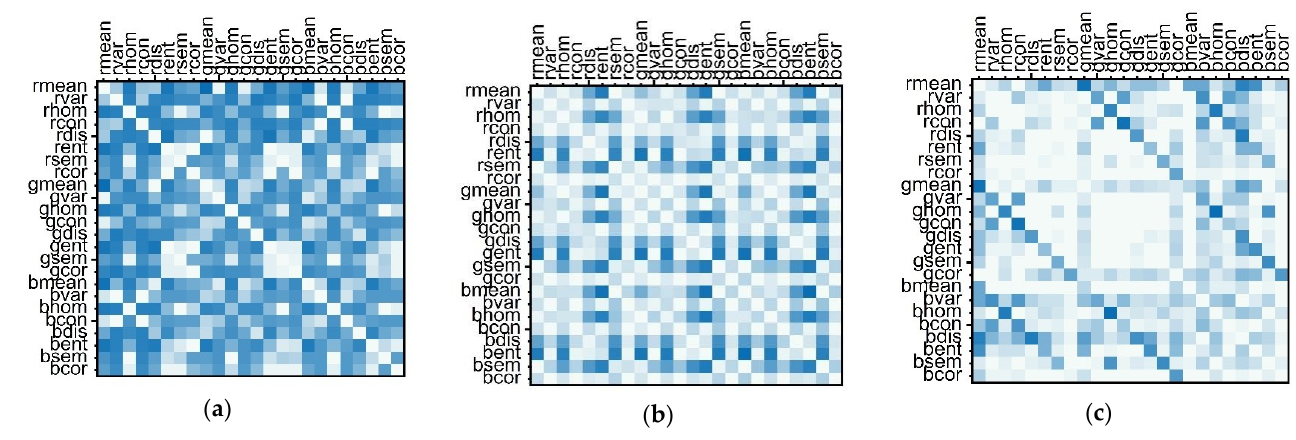
Figure 10. R 2 value of the normalized differential texture index-based linear regression models for estimating aboveground biomass at the ( a ) seedling stage, ( b ) post-seedling stage, and ( c ) across all stages. Table 7. Performance of the five best normalized differential texture index-based linear regression models based on the calibration dataset. Seedling